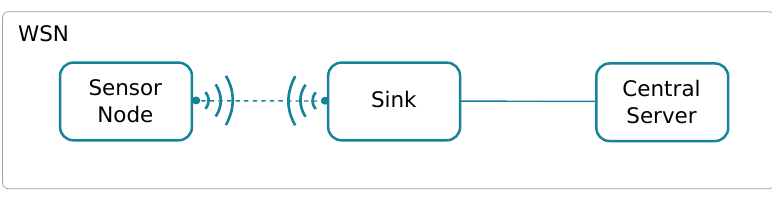
Figure 6. Wireless Sensor Network structure.